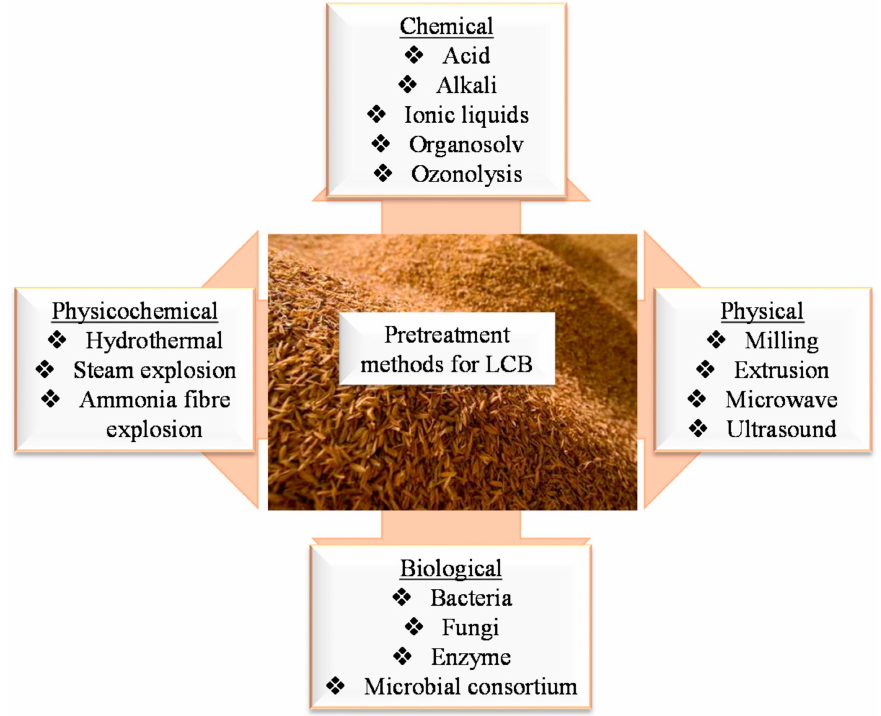
Figure 3. Typical and recent pre-treatment methods for